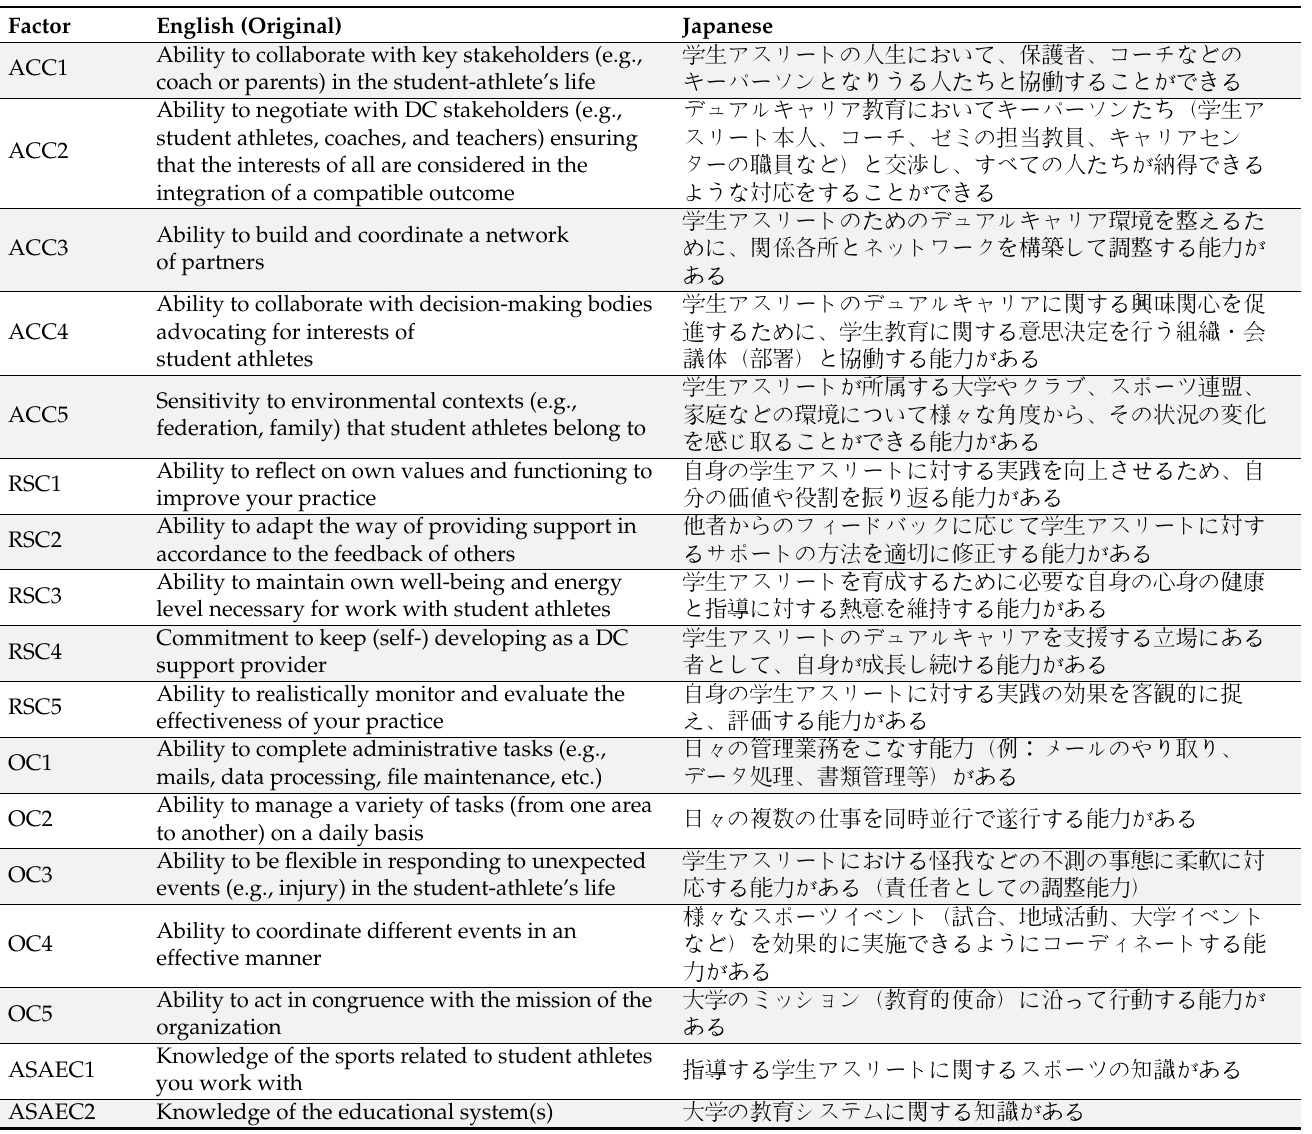
Table 2. Competency items for English to Japanese